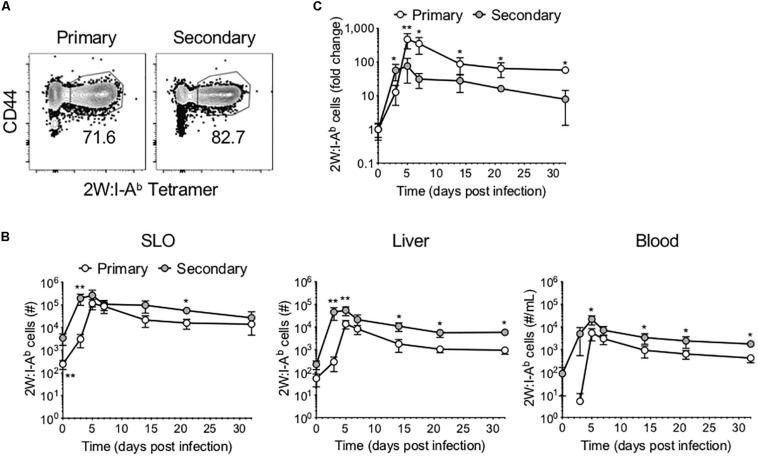
Ag-specific CD4+ T cells expand and contract more rapidly following secondary infection. Following primary or secondary Lm infection, the number of 2W:I-Ab-specific CD4+ T cells within secondary lymphoid organs (SLOs), liver and blood was assessed at 0, 3, 5, 7, 14, 21, and 32 dpi. (A) Representative flow cytometry plots of 2W:I-Ab-specific CD4+ T cells in SLOs at 5 dpi, after excluding doublets, dead cells, B cells, macrophages, dendritic cells, and CD8+ T cells as described in the materials and methods. (B) Number of 2W:I-Ab-specific CD4+ T cells in SLO, liver and blood. (C) Fold change of 2W:I-Ab-specific CD4+ T cell expansion during primary versus secondary Lm infection. Data are compiled from two to three independent experiments per time point with n = 1–4 mice per experiment. *P < 0.05, **P < 0.01 as determined by Mann Whitney U test. Bars represent mean ± SD.